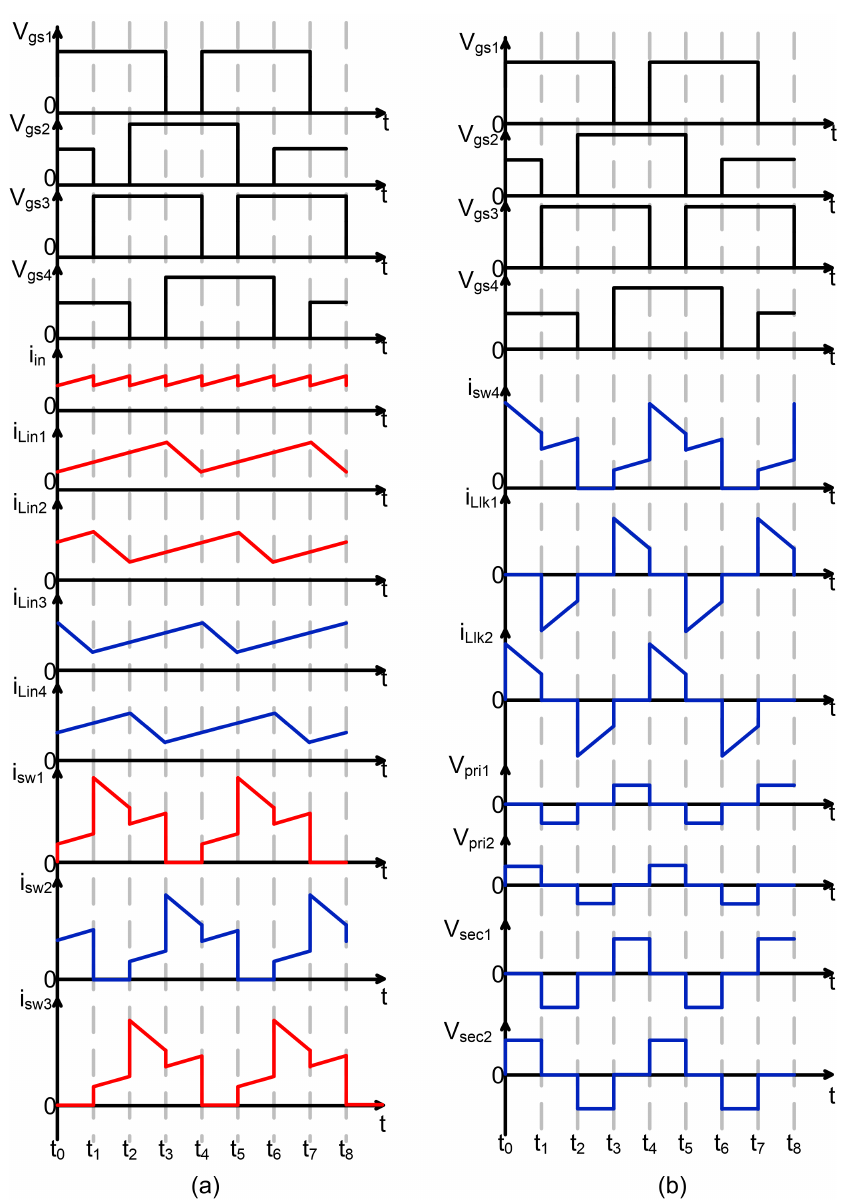
Figure 2. Theoretical steady state waveforms of the proposed converter: ( a ) Boost converter waveforms; ( b ) High frequency transformer